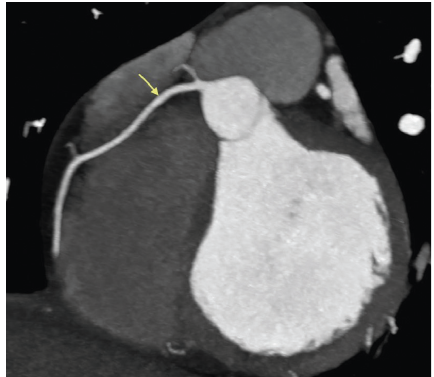
Figure 5: Coronary CT angiogram image revealing the distal segments and diagonal branches of LAD are normal without any evidence of coronary artery disease.